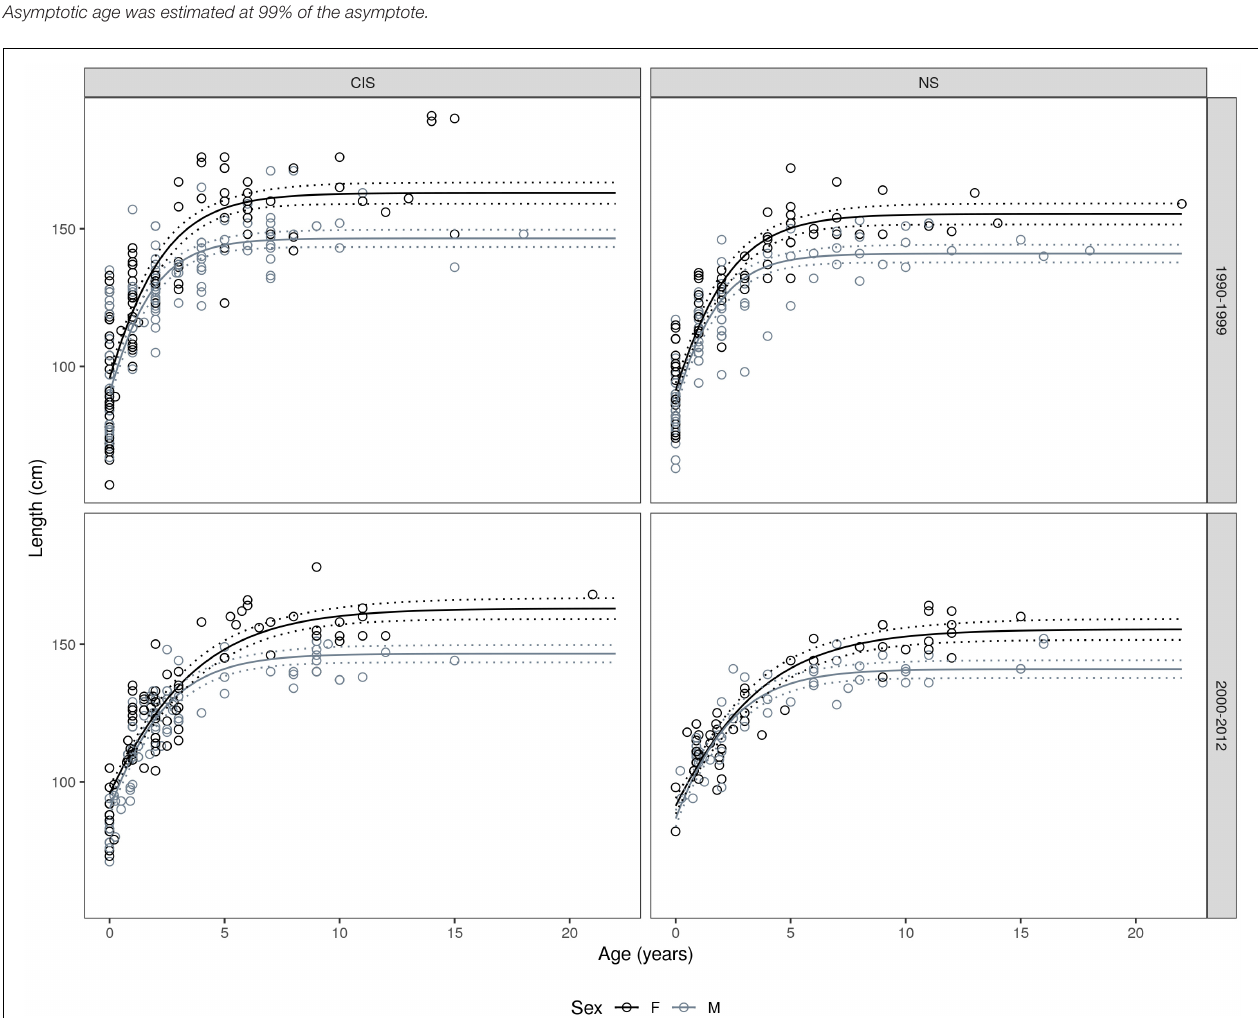
FIGURE 3 | Gompertz growth models fitted to the length-at-age data; fitted by management unit, time period, and sex (see Table 2 for n values and growth parameters). Stippled lines represent the 95% confidence intervals for the growth curves.